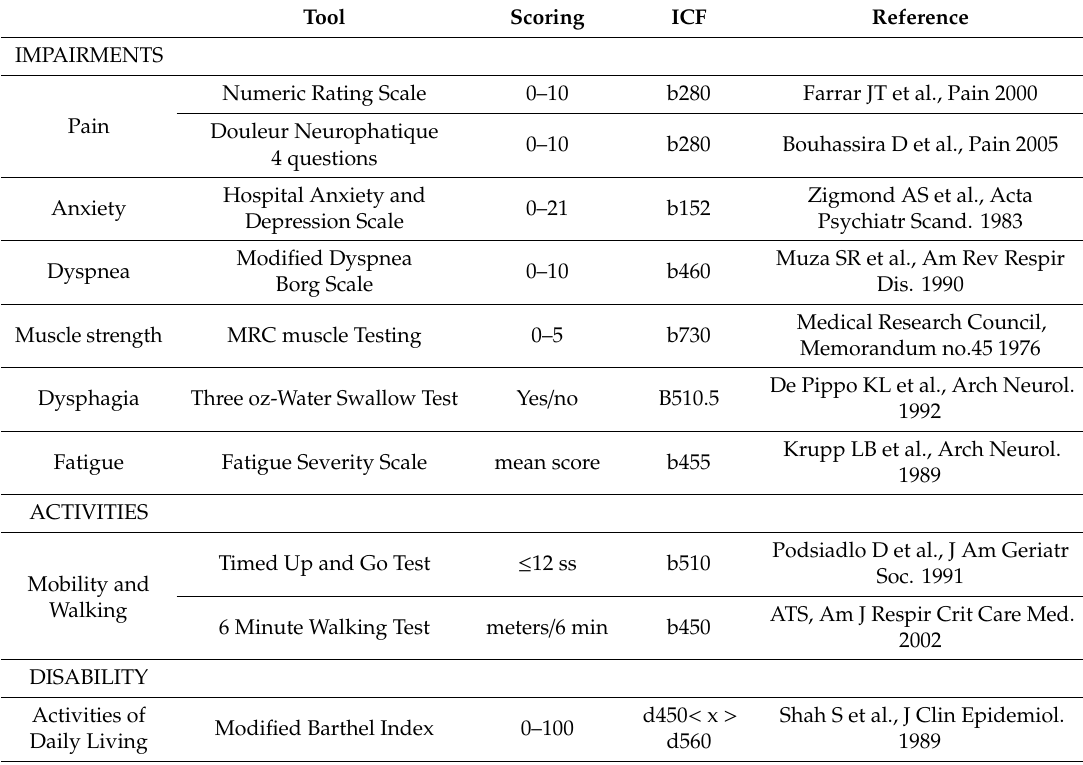
Table 1. Minimum assessment tools